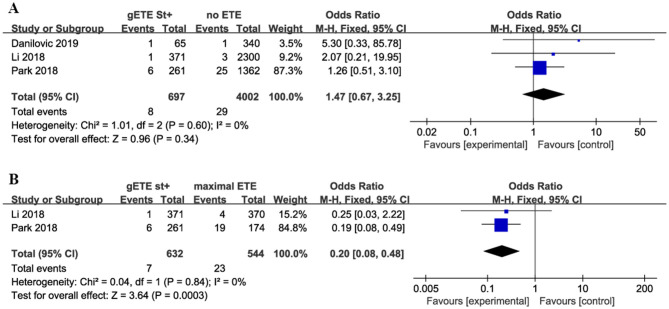
Forest plot for overall mortality comparison between gETE st+ with (A) no ETE (B) maximal ETE.